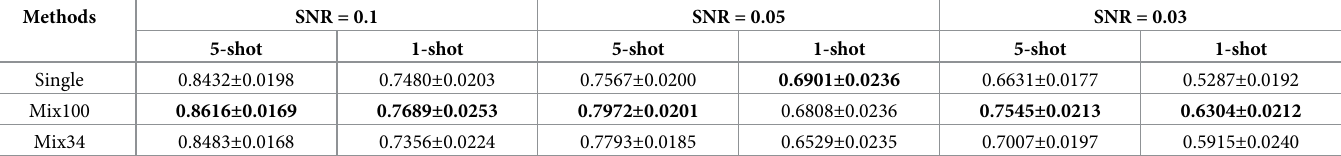
Table 3. The classification accuracy of the simulated datasets with different settings of mix training strategy on ProtoNet3D. Single means the model trained on the dataset with single SNR. Mix100 means the model trained on the dataset with 100 samples for each SNR level. And Mix34 means the model trained on the dataset with 34,33 and 33 samples with SNR = 0.1, 0.05, and 0.03, respectively.